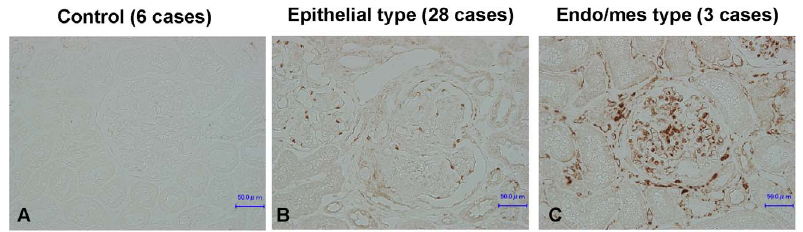
Figure 1. Gas6 expression in human IgA nephropathy. Biopsy samples were immunostained using indirect immunohistochemistry procedure with anti-Gas6 antibody. Representative images are shown in (A) from control patients, (B) from IgA nephropathy cases immunostained in epithelial cells, and (C) from IgA nephropathy cases immunostained in endothelial and mesangial cells. The original magnification was X200. Endo/mes, Endothelial and